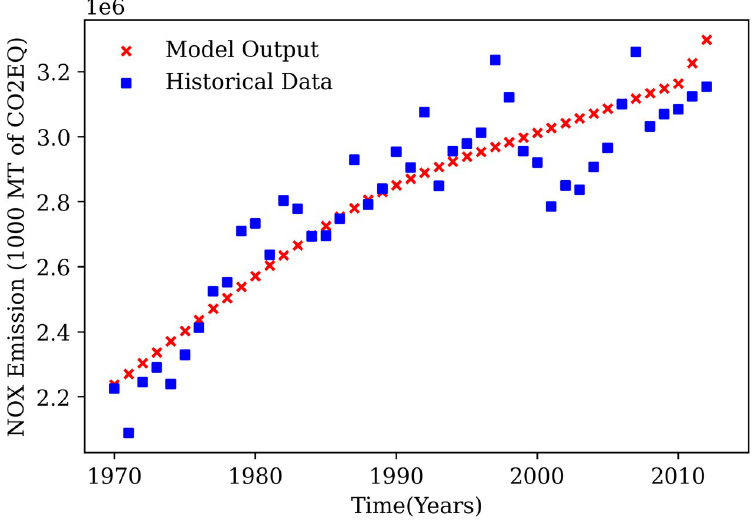
Fig 6. Comparison of NO X emissions predicted by GGSM to historical global nitrous oxide emissions.